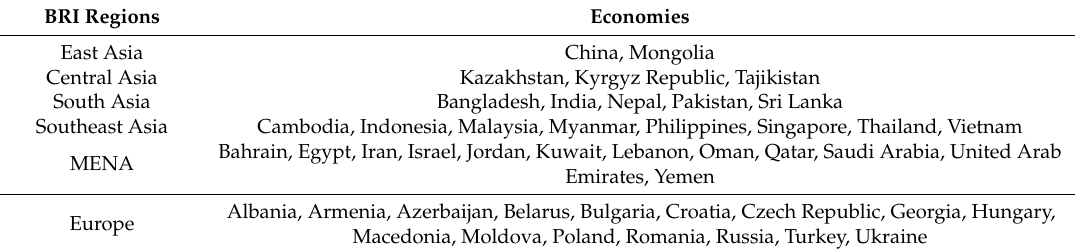
Table 1. BRI regions and Economies.